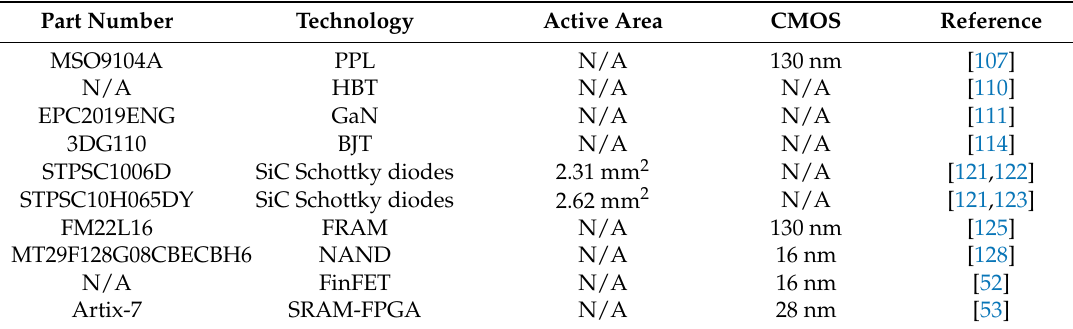
Table 5. Characteristics of the studied Schottky diodes.